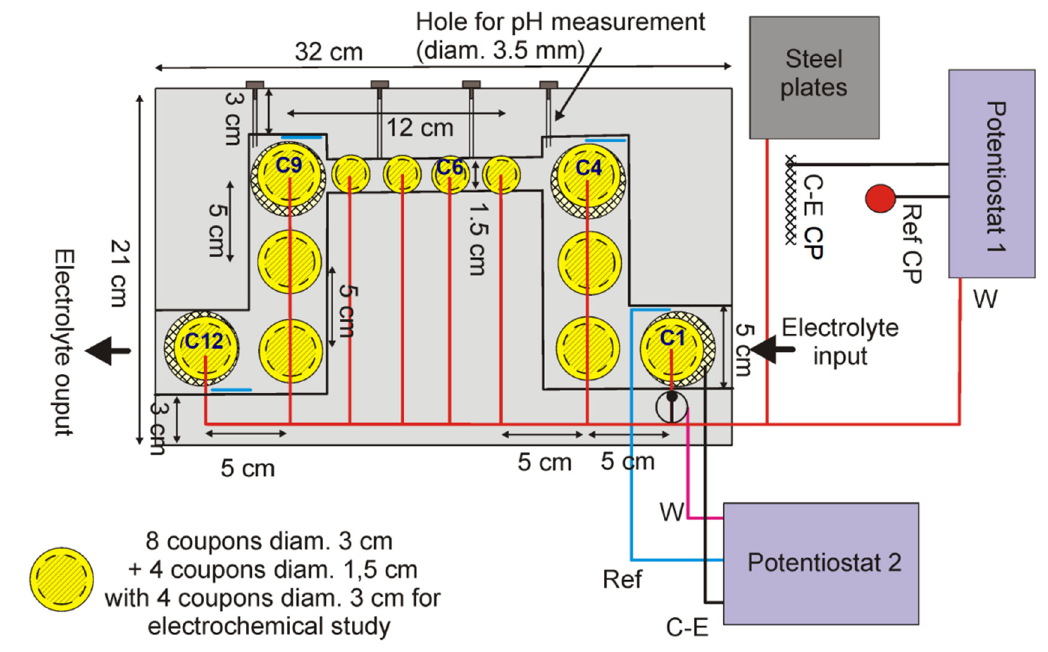
Figure 2. Schematic view (side) of the experimental device, showing the electrical connections and the positions of the four Ag/AgCl microelectrodes (blue lines) set in the channel close to coupons C1, C4, C9 and C12.